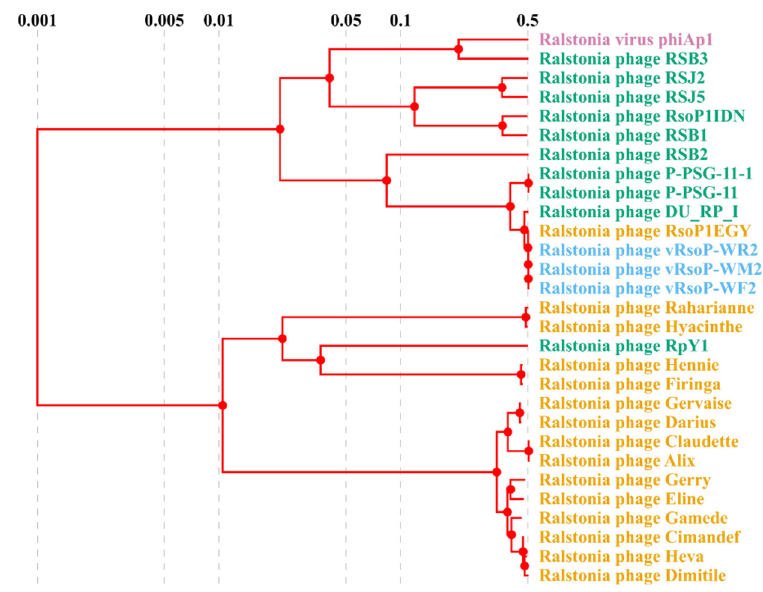
Figure 7. Phylogenetic proteomic tree of European water phages vRsoP-WF2, vRsoP-WM2 and vRsoP-WR2 with a selection of closely related R. solanacearum and R. pseudosolanacearum phages from other sources and continents using the ViPTree. The geographical origin of the phages is indicated by the following colours: Africa (orange), Asia (green), Europe (blue) and America (purple).